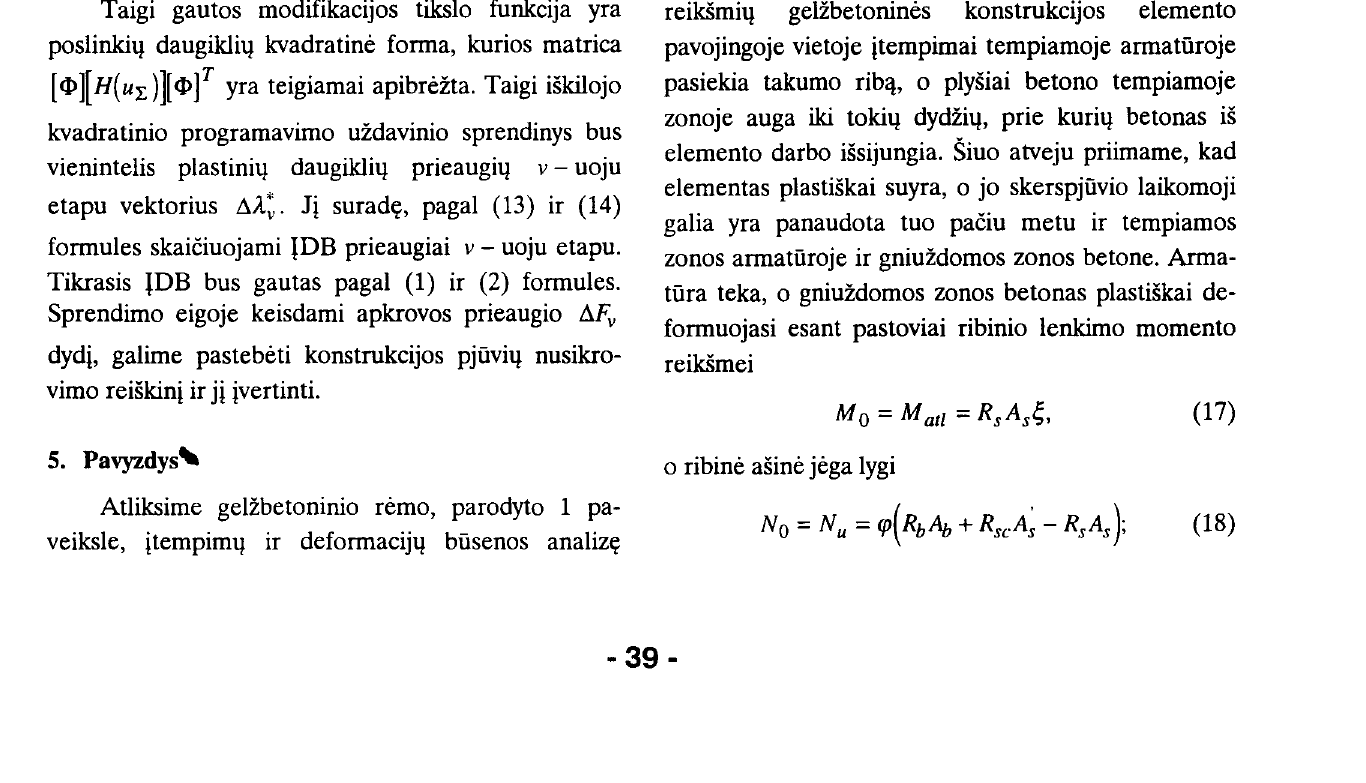
1 pav. Remo geometrija ir diskretinis modelis Fig 1. Geometry and discrete